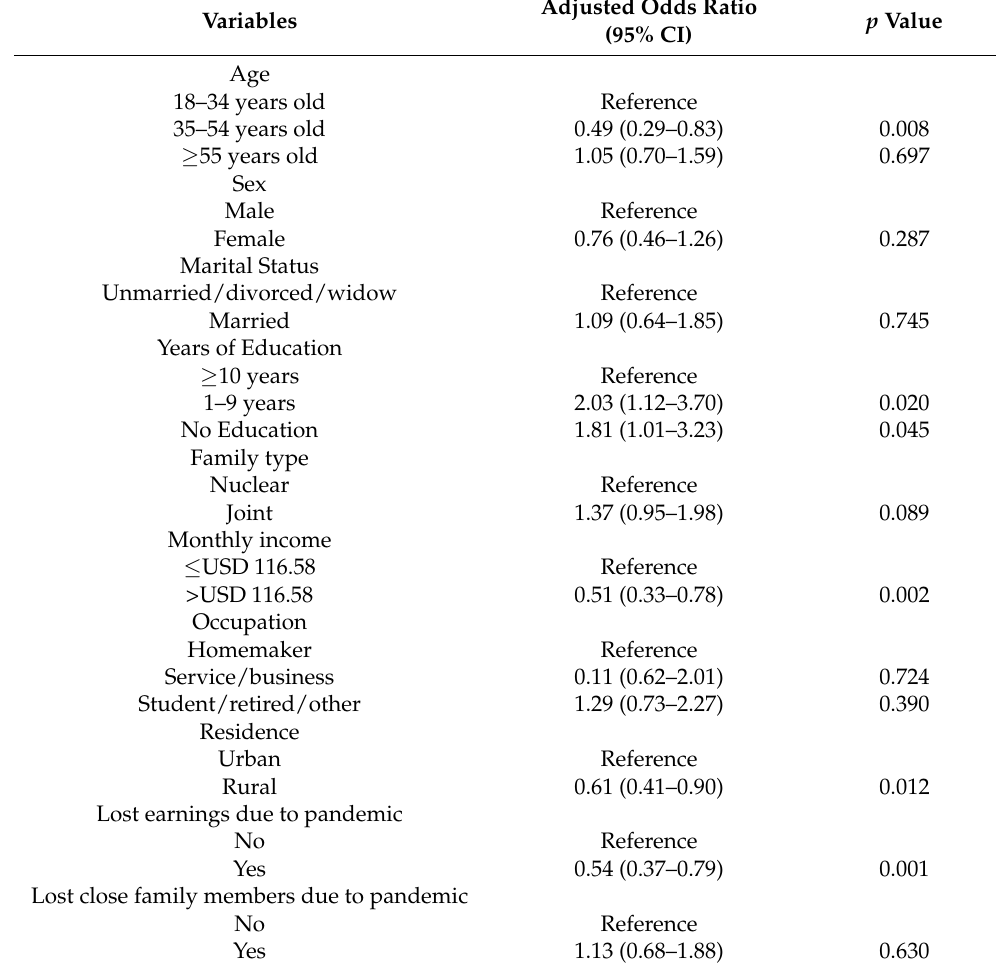
Table 5. Binomial logistic regression analysis exploring factors associated with WRTCCD